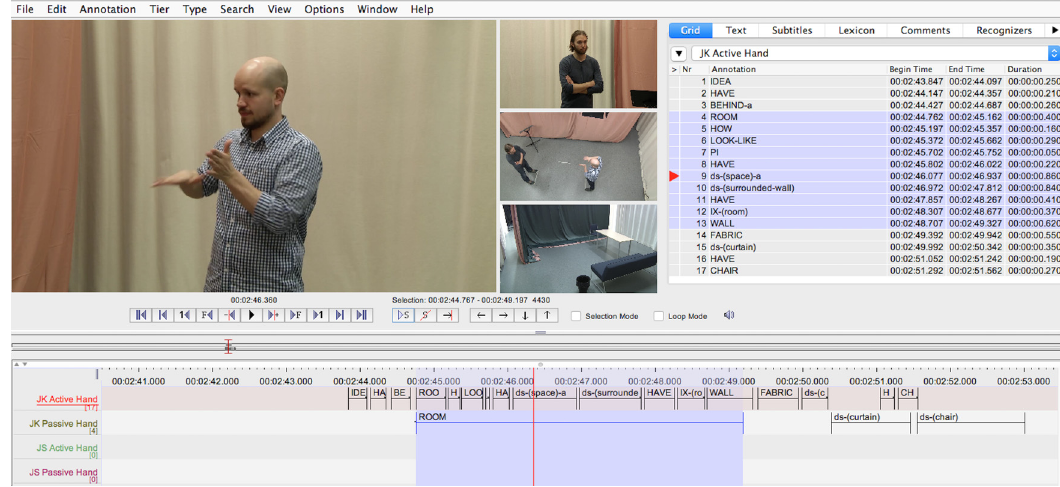
Figure 6: A screenshot from the ELAN annotation tool used for transcribing and analyzing the data.